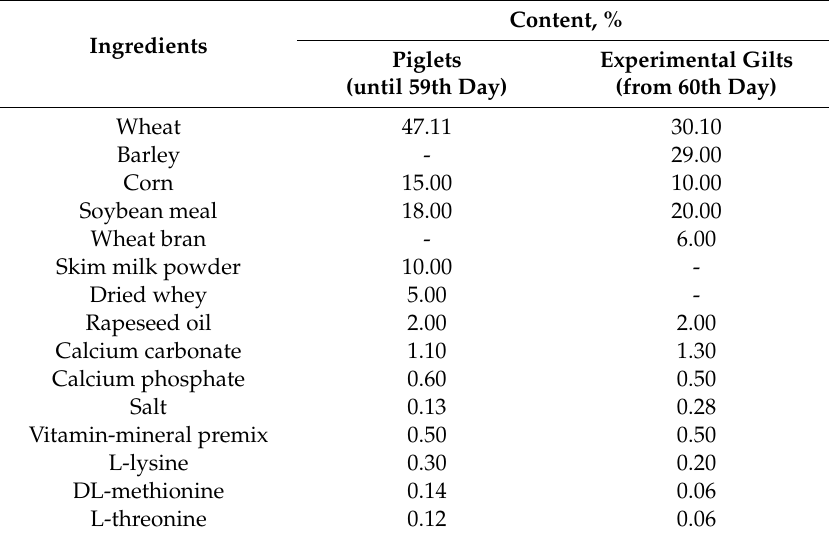
Table 2. Composition of feed mixtures used for o ff